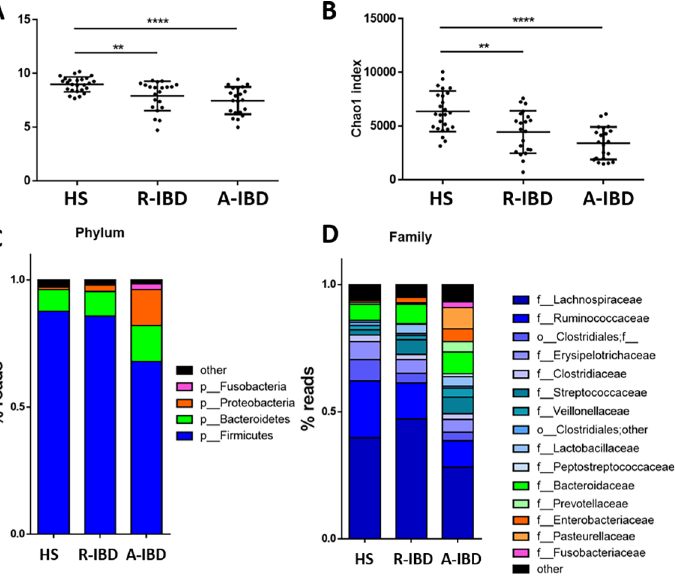
Fig 4. Bacterial diversity and composition among healthy subjects (HS), IBD in remission (R-IBD) and in flare (A-IBD): alpha diversity Shannon index (A) and Chao 1 index (B) and composition at a phyla scale (C) and at family scale